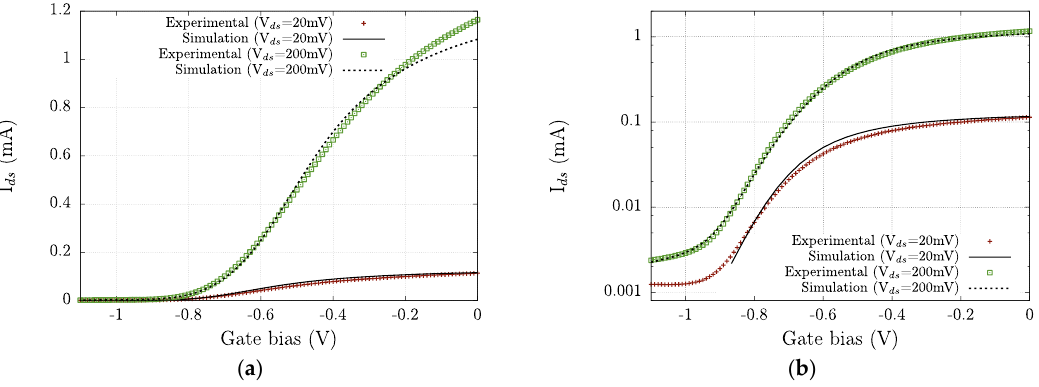
Figure 4. ( a ) Experimental and simulated transfer characteristics of the strained-Si MODFET for two values, 20 mV and 200 mV, of the drain voltage; ( b ) experimental and simulated transfer characteristics with current plotted in log scale.